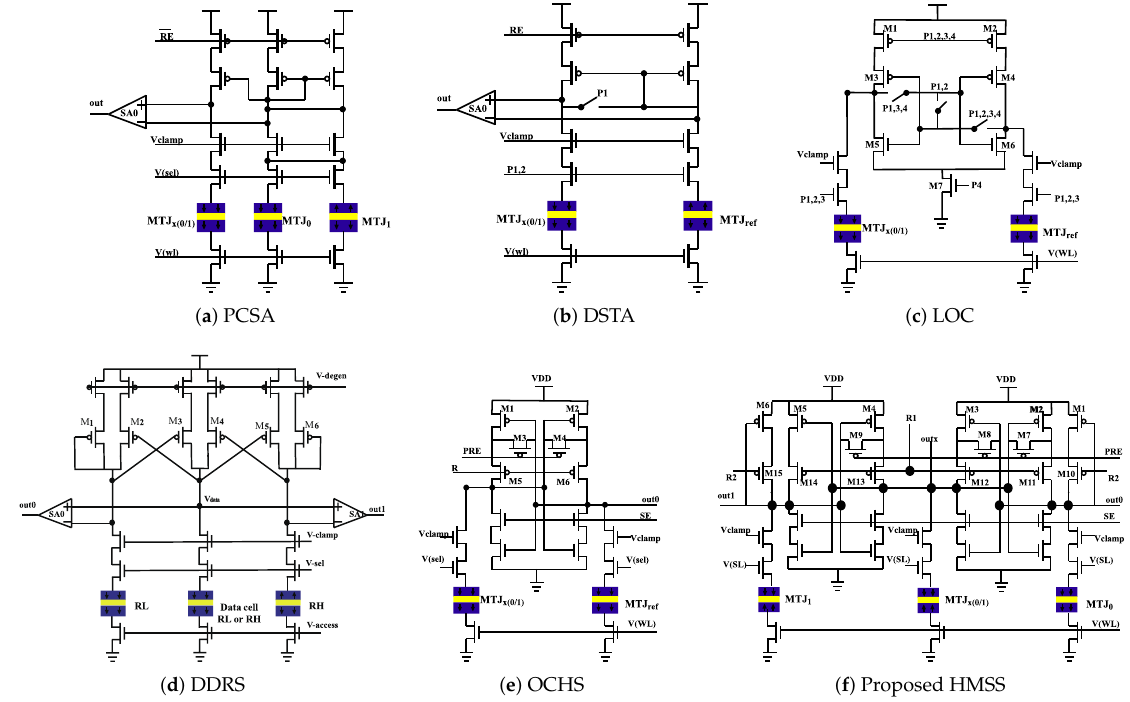
Figure 1. The schematics of sensing circuits. ( a ) Pre-charge SA (PCSA) [27]. ( b ) Double switches and transmission gate access transistor (DSTA) SA [28]. ( c ) Latch offset cancellation (LOC) SA [29]. ( d ) Dynamic dual-reference (DDRS) SA [30]. ( e ) Offset-compensated high-speed (OCHS) SA [31]. ( f ) High-sensing margin, high speed and stability